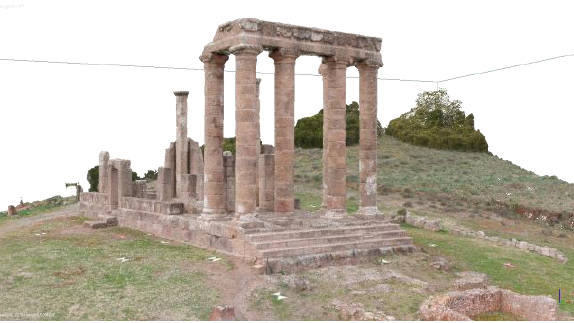
Figure 9. 3D textured mesh